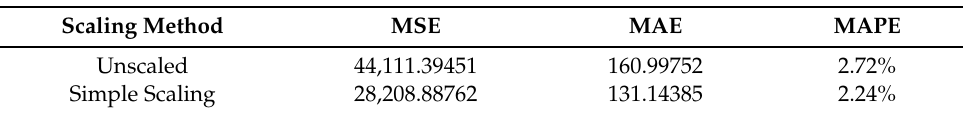
Figure 3. Graphic comparison of actual and predicted hourly load values for the year 2017. The values predicted through the simple scaling method are added. Table 2. MSE, MAE and MAPE values for the hourly load forecast. Input data are subjected to a simple scaling